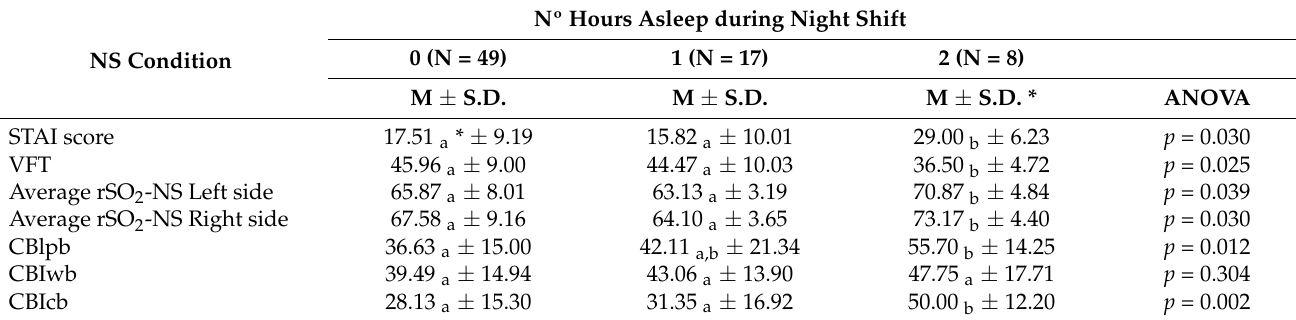
Table 2. Relationship between number of hours of sleep and the main variables measured in NS